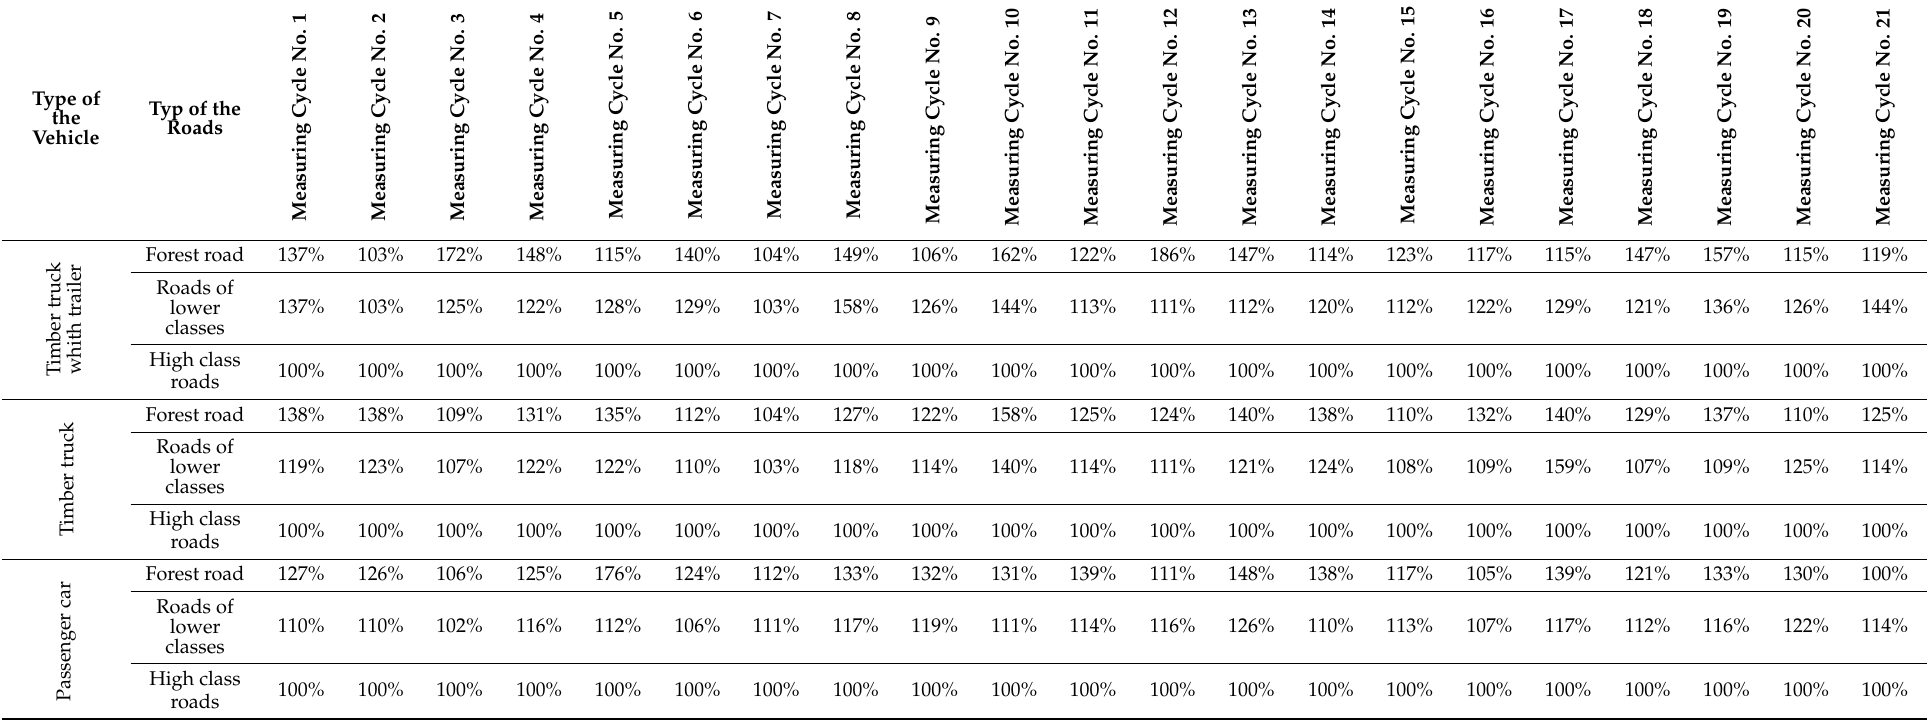
Table 2. Summary relative comparison of muscle load when driving a work vehicle by vehicle type when driving different types of work trips in the work cycle (one work day,